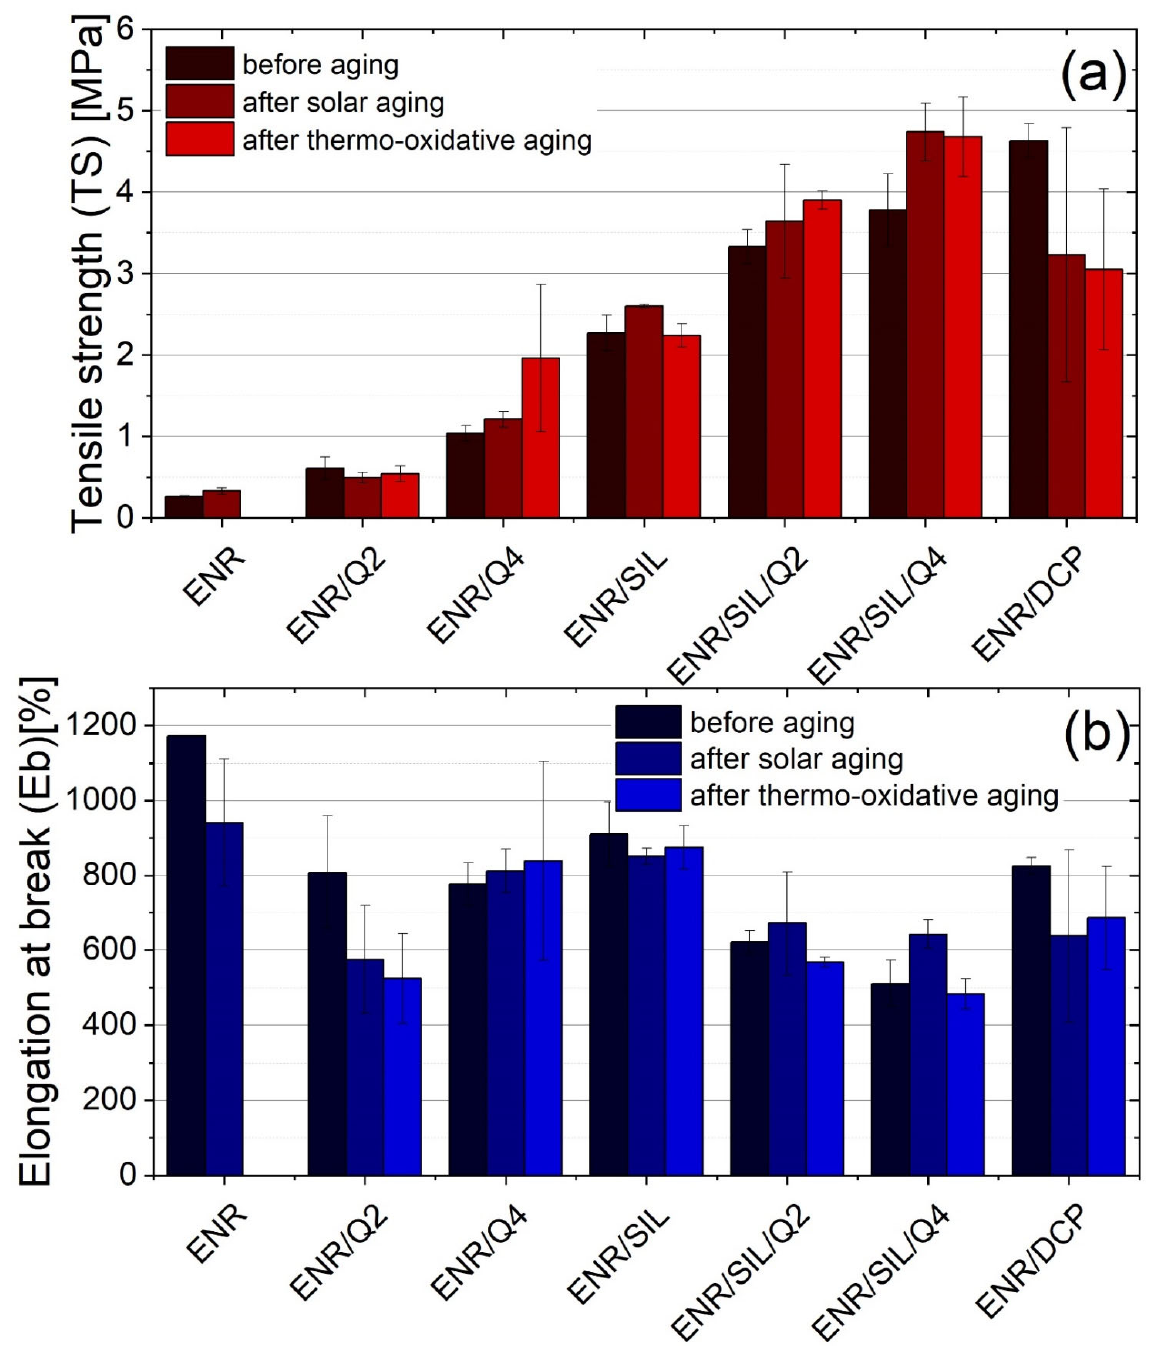
Figure 3. Tensile strength results (TS) ( a ), elongation at break ( b ).